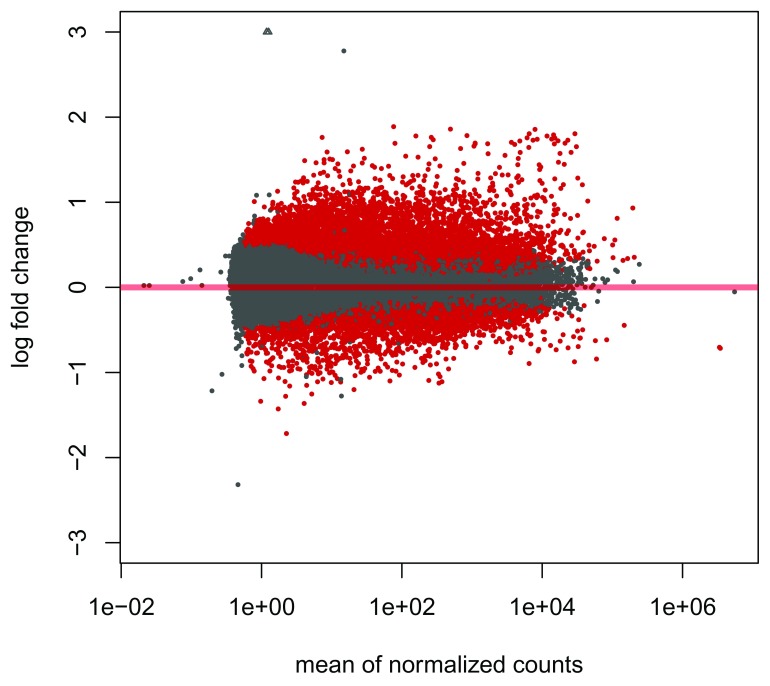
MA plot showing genes differentially expressed (red dots) in SLE patients compared to healthy patients.